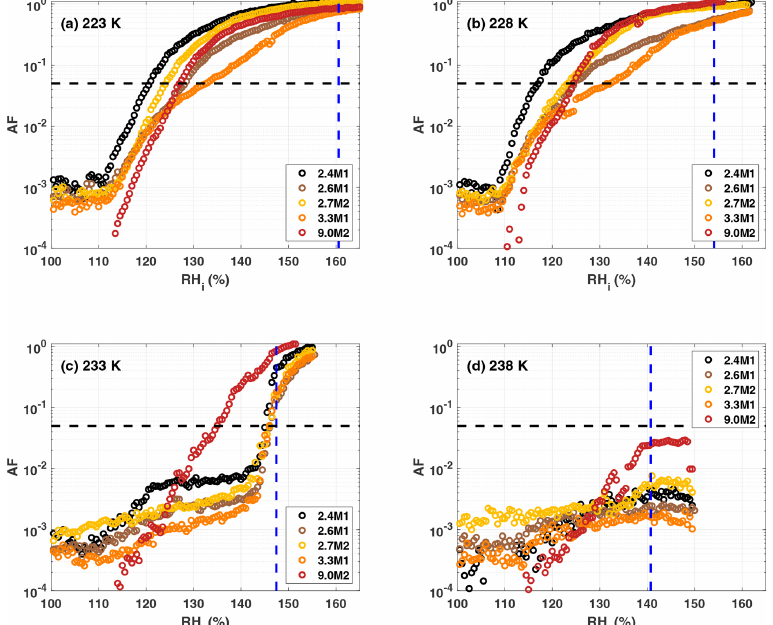
Figure A2. Activated fraction (AF) curves for the methylated samples as a function of RH i at (a) 223K, (b) 228K, (c) 233K and (d) 238K. The blue dashed vertical line represents the RH i corresponding to water saturation. The black dashed horizontal line indicates the AF 0 . 05